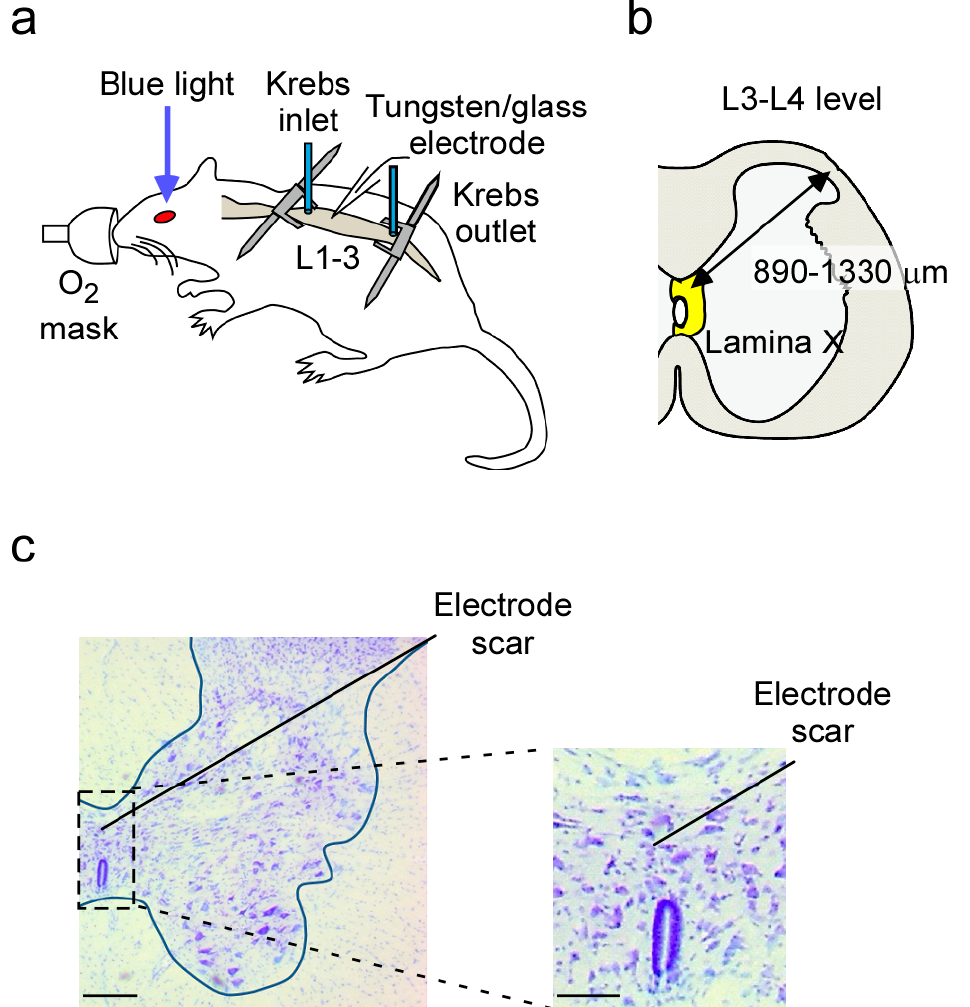
Figure 1. In vivo electrophysiological recording from lamina X neurons in the rat spinal cord. ( a ) Schematic diagram of the electrophysiological recording and perfusion system. The lumber spinal cord was exposed by laminectomy and the surface of the cord was perfused continuously with warmed pre-oxygenated Krebs solution. Known concentrations of drugs were applied from the same line. The body temperature was monitored and kept at the normal range. ( b ) Schematic drawing of the transverse slice of lumbar cord and of the angle of a recording electrode (two-way arrow). Recordings were made from cells at a depth of 890–1330 µ m (shown by two-way arrow) from the surface of spinal cord. ( c ) A representative image of the Nissl-stained spinal cord section after insertion of a tungsten electrode. The blocked area is enlarged. Scale bars, 100 µ m in the low magnification, 50 µ m in the high magnification.